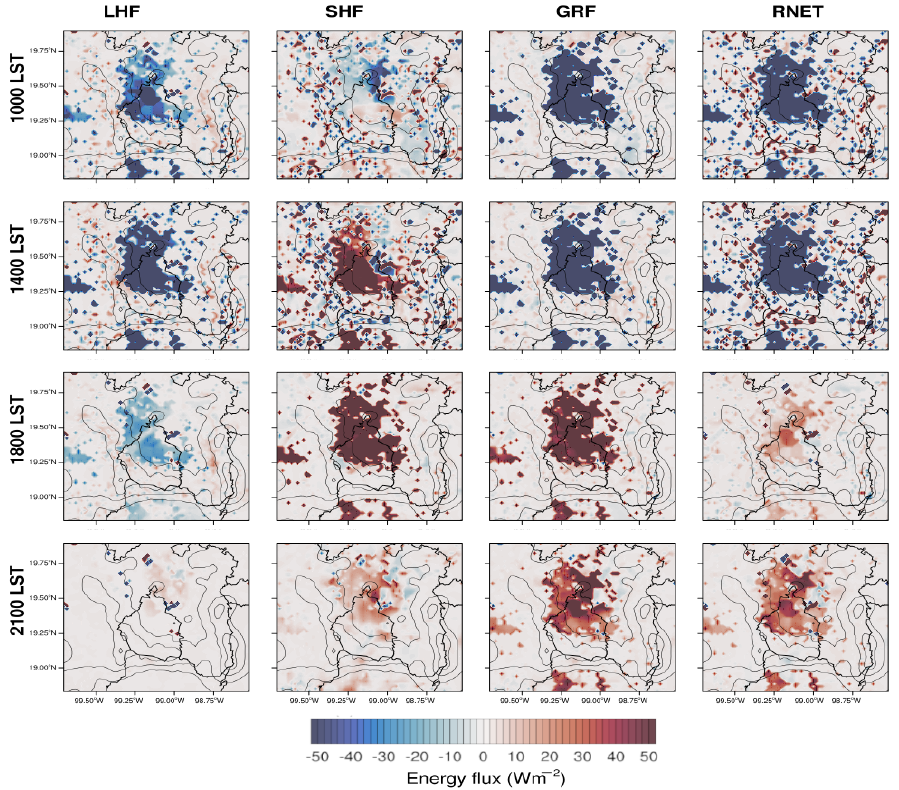
Figure 9. Urban effect as the difference in energy fluxes W m − 2 at the surface between the CTRL simulation and the NATX experiment for February 10 at 1000, 1400, 1800, and 2100 LST. Columns 1, 2, 3 and 4 are for latent heat fluxes (LHF), sensible heat fluxes (SHF), ground flux (GRF), and net radiation, respectively. Positive direction for fluxes implies atmosphere receives energy from the surface